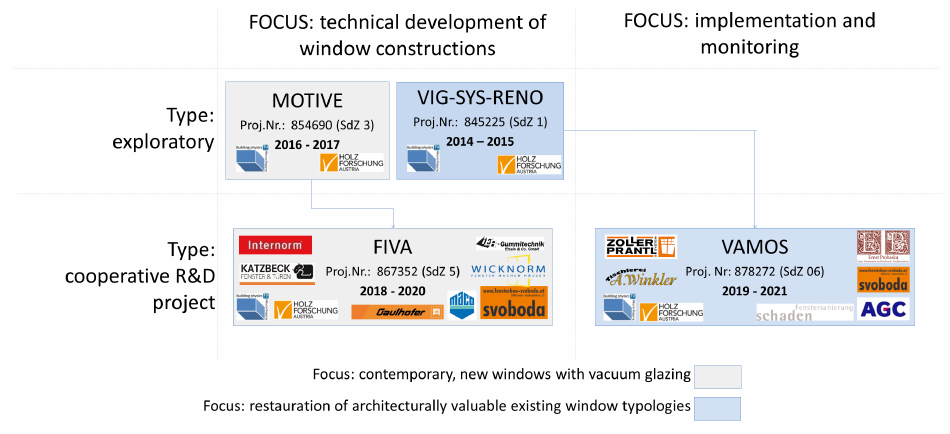
Figure 3. Landscape of R&D projects pertaining to vacuum glass integration into new and existing windows.